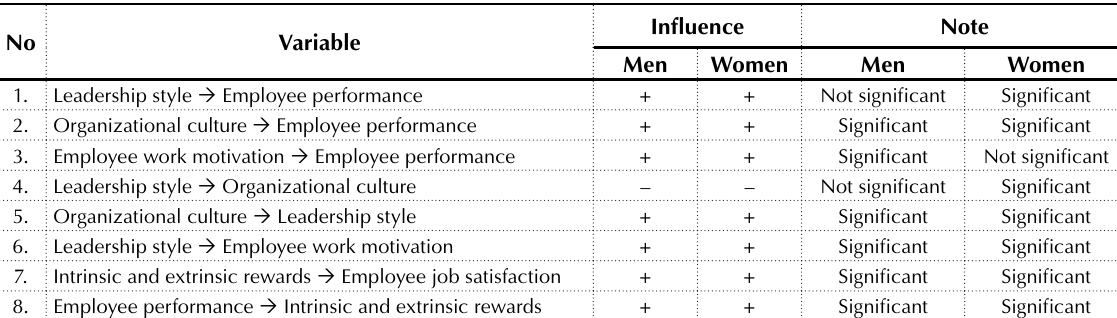
Table 2. Hypothesis test of the model of relations between variables on male and female middle managers